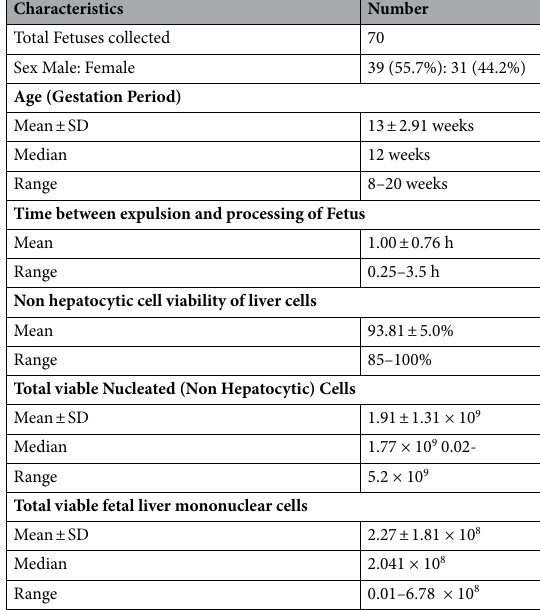
Table 2. Fetal liver characteristics at the time of